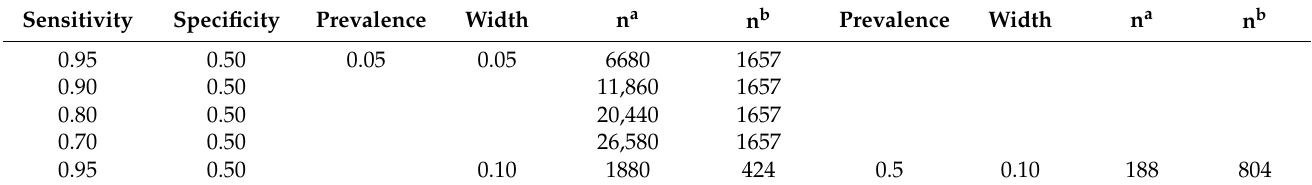
Table 3. Recommended sample size requirements involving research for a screening purpose that emphasizes a degree of sensitivity that is based on its 95% confidence